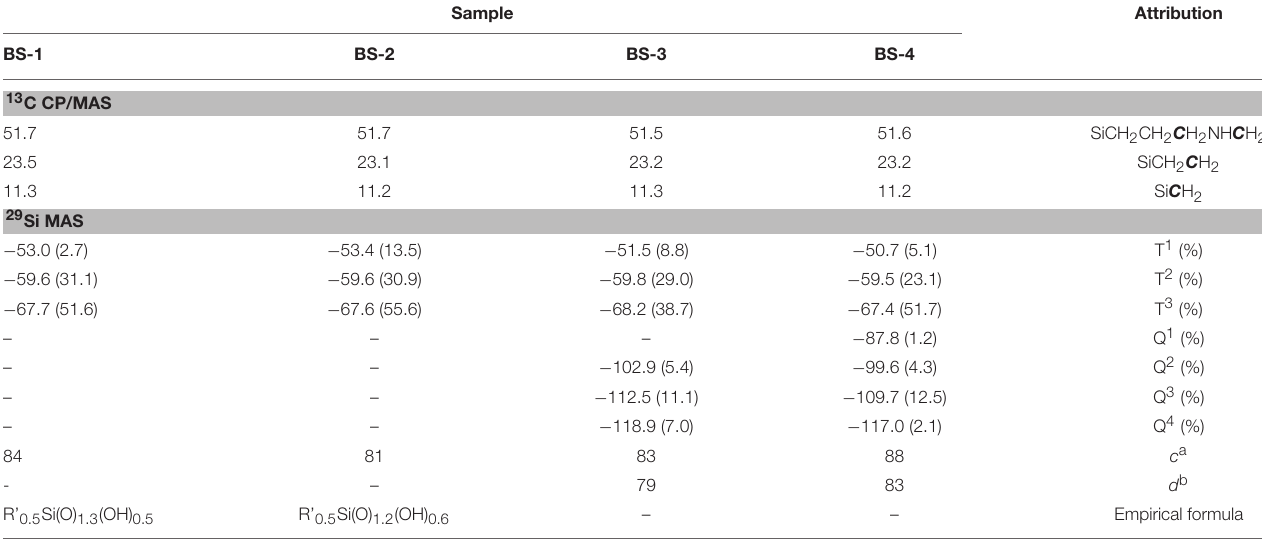
TABLE 1 | 13 C CP/MAS and 29 Si MAS NMR data ( δ in ppm) of the BSs hybrids. R’ stands for –(CH 2 ) 3 NH(CH 2 ) 3 − . Sample Attribution